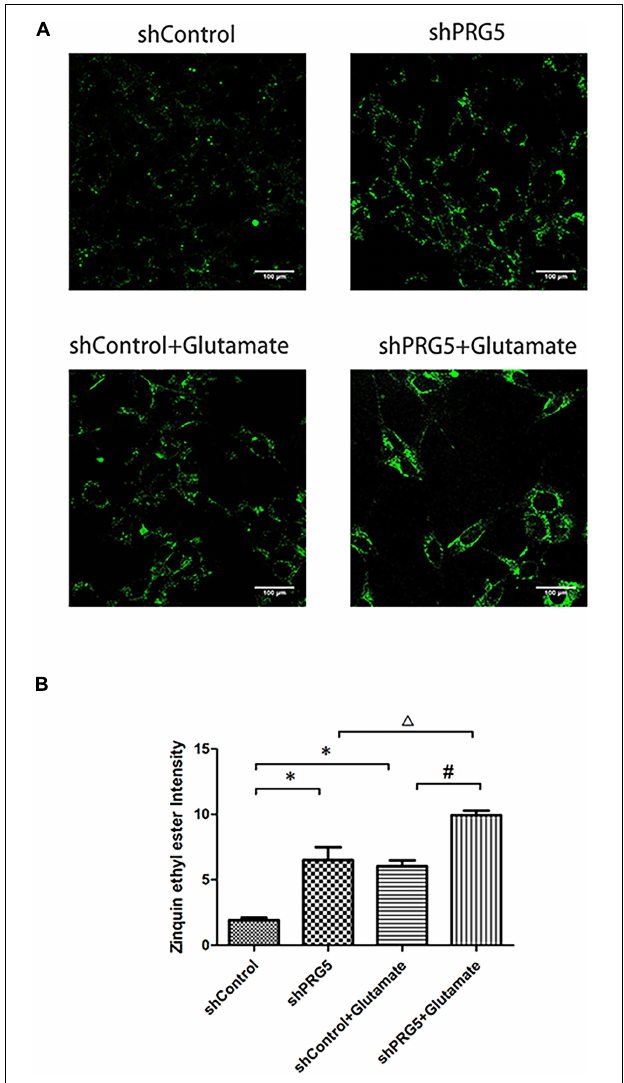
FIGURE 6 | The effect of PRG5 gene silencing and glutamate treatment on the cellular zinc ion levels in HT22 cells. (A) The fluorescence intensity of Zinquin ethyl ester in HT22 cells; (B) the quantitative analysis of the average fluorescence intensity of Zinquin ethyl ester in HT22 cells. ∗ P < 0.05 compared with shControl group, (cid:77) P < 0.05 compared with shPlppr5 group, # P < 0.05 compared with Control + Glutamate group ( n =